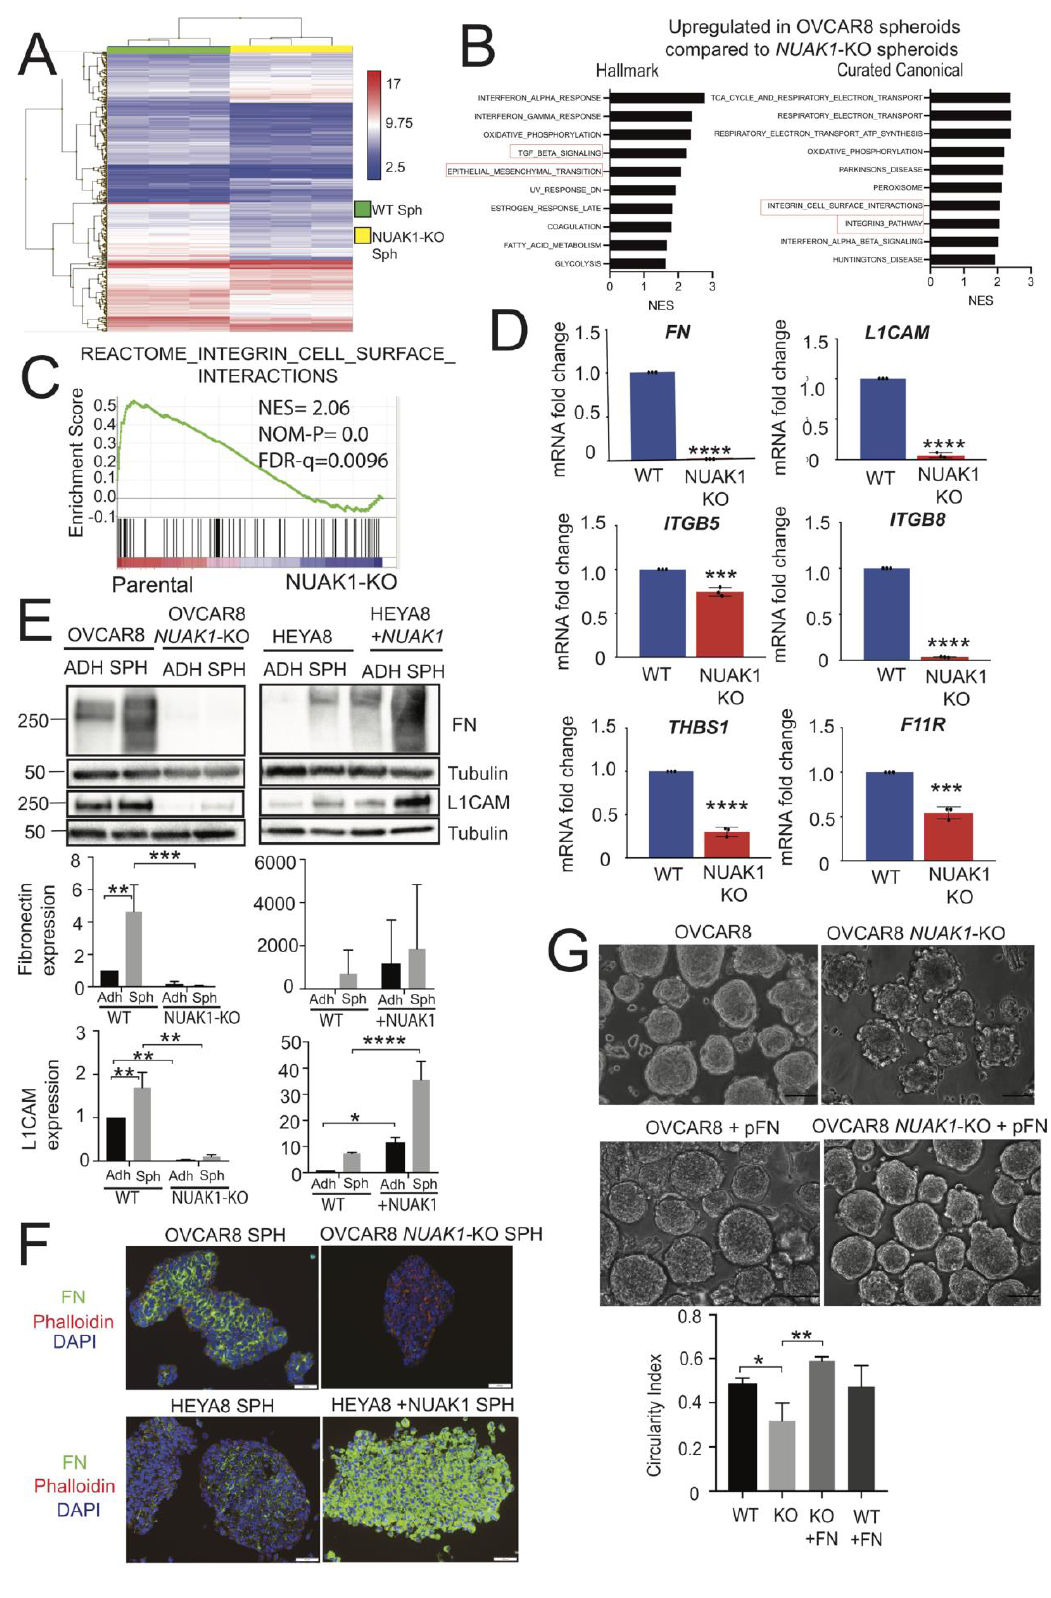
Figure 4. NUAK1 promotes fibronectin expression in EOC spheroids. ( A ) Hierarchical clustering heat map showing gene expression profiles for OVCAR8 and OVCAR8- NUAK1 KO spheroids (n = 3). Up-regulated (red) and down-regulated (blue) genes with a fold change ≥ 2 or ≤ −2 and p < 0.05 are shown. ( B ) Top 10 gene sets up-regulated in OVCAR8 spheroids when compared with OVCAR8- NUAK1 KO spheroids presented as normalized enrichment score (NES) using the GSEA